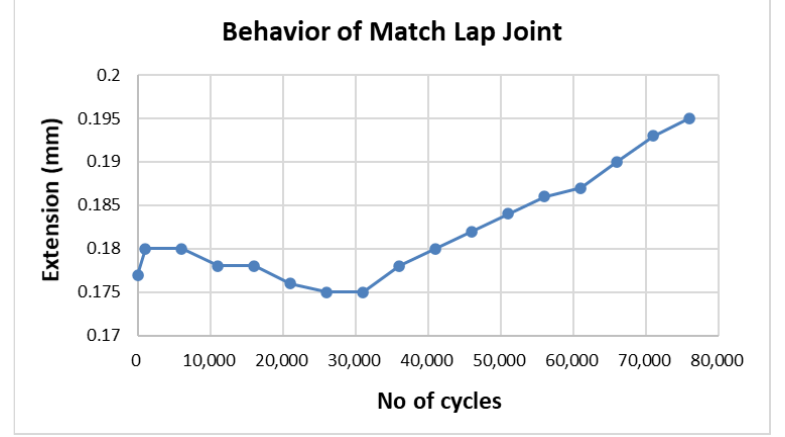
Figure 8. Fatigue crack growth in double strap match lap joint (specimen 3, sample 2).